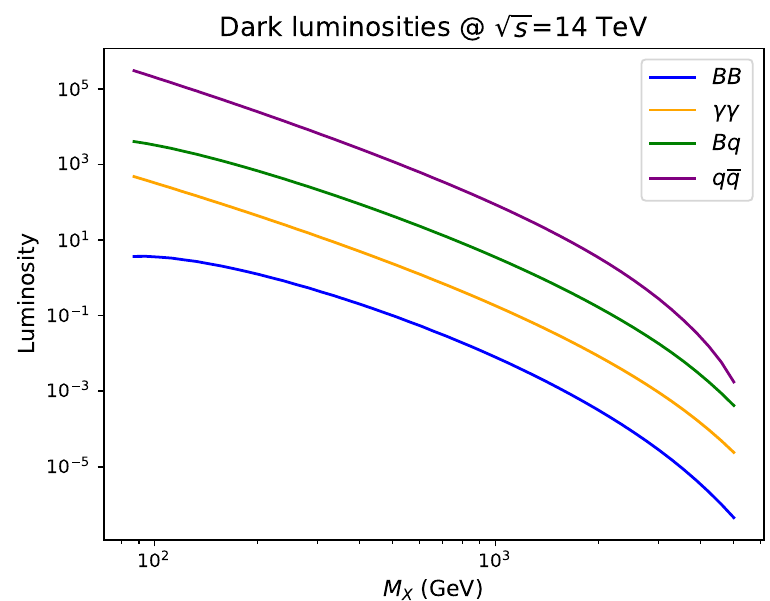
Figure 4 . Comparison of the absolute value of the Φ BB , Φ qB central luminosities and the Φ γγ and Φ central luminosities as a function of the invariant mass M qq √ s = 14 TeV for the dark PDF set obtained with the dark photon coupling and mass set in eq.